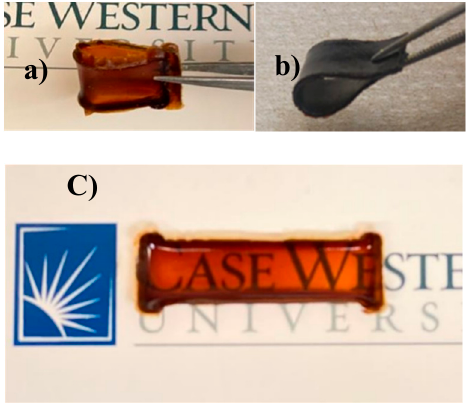
Figure 6. Optical photographs of CA-pdms-fu films ( a , b ) and poly (CA-pdms-fu) ( c ).